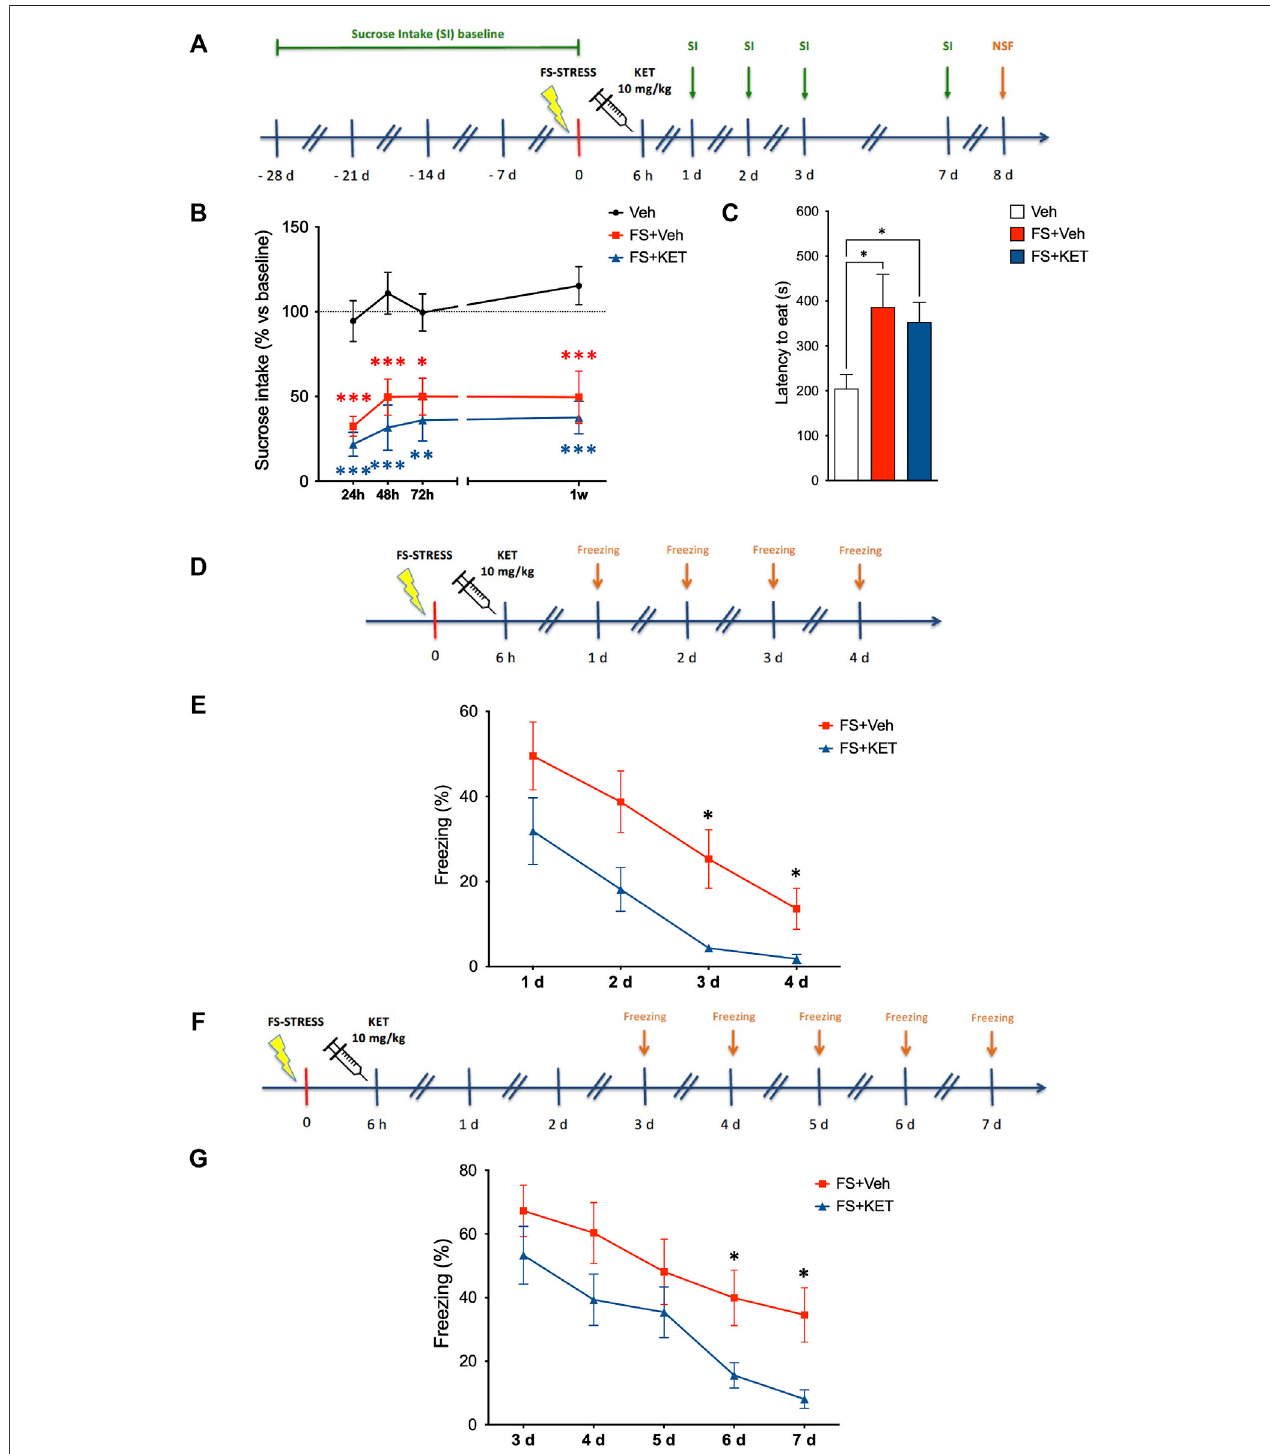
FIGURE 4 | Behavioral studies. (A) Experimental plan timeline for panels (B,C) . Basal sucrose intake (SI) was established exposing the rats to SI test twice a week for4 weeks.AnimalswerethansubjectedtoFSandinjectedwithsaline(Veh)orketamine(KET)6 hafterthebeginningofthestresssession.SItestwasperformedagain 1, 2,3,and 7 daysafter FS. Thesame ratswerealso exposedtothenovelty-suppressedfeeding(NSF)test8 days after FS. Sucroseintake (B) and novelty-suppressed feeding (C) of rats injected with saline (Veh), subjected to acute FS, and injected with saline 6 h after stress (FS + Veh) or subjected to acute FS and injected with ketamine 6 h after stress (FS + KET). In (B) , changes in sucrose intake were measured 24 h, 48 h, 72 h and 1 week after stress exposure, and data are expressed as